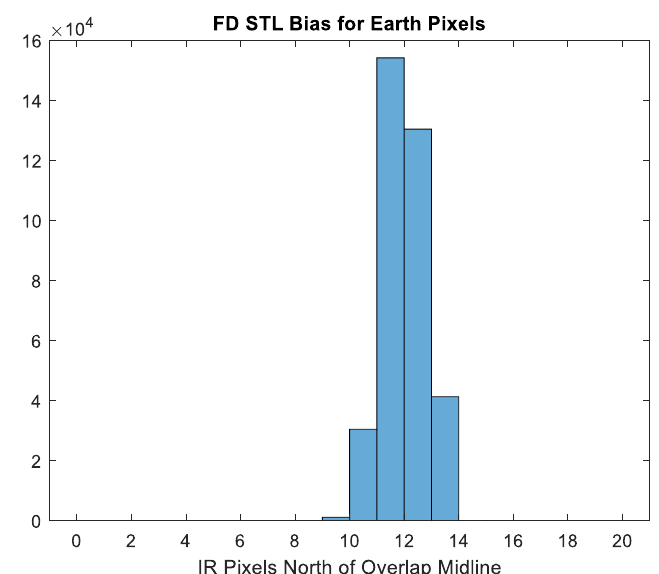
Figure A1. The swath transition line (STL) interior to the Earth is represented by blue dots and the overlap bisections are drawn in green. The complete FD is shown to the left with a zoom to the right .